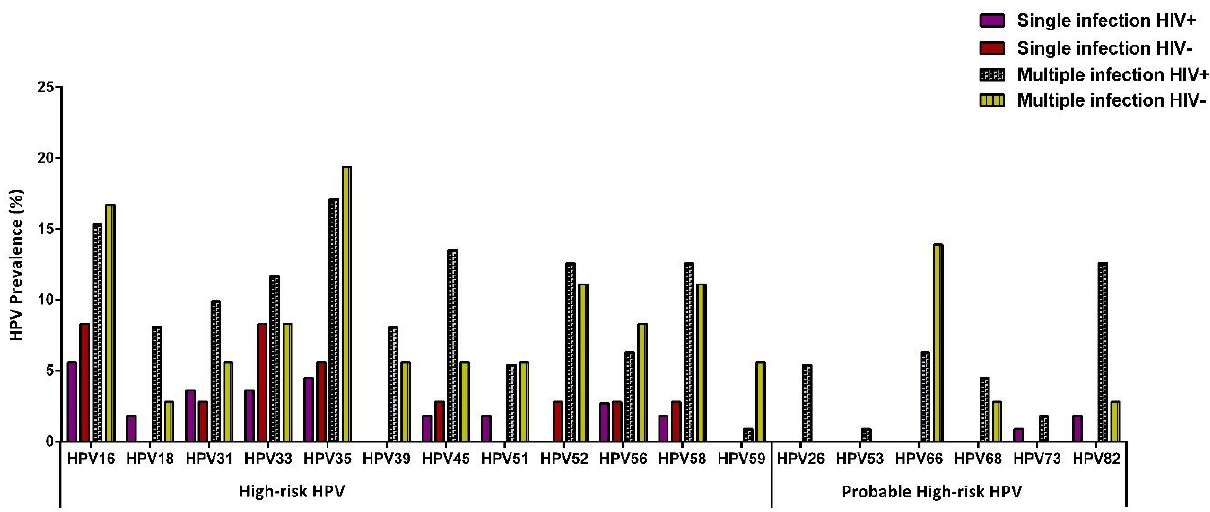
Figure 4. Distribution of HPV types among women with CIN3 in single and multiple infections according to HIV status.